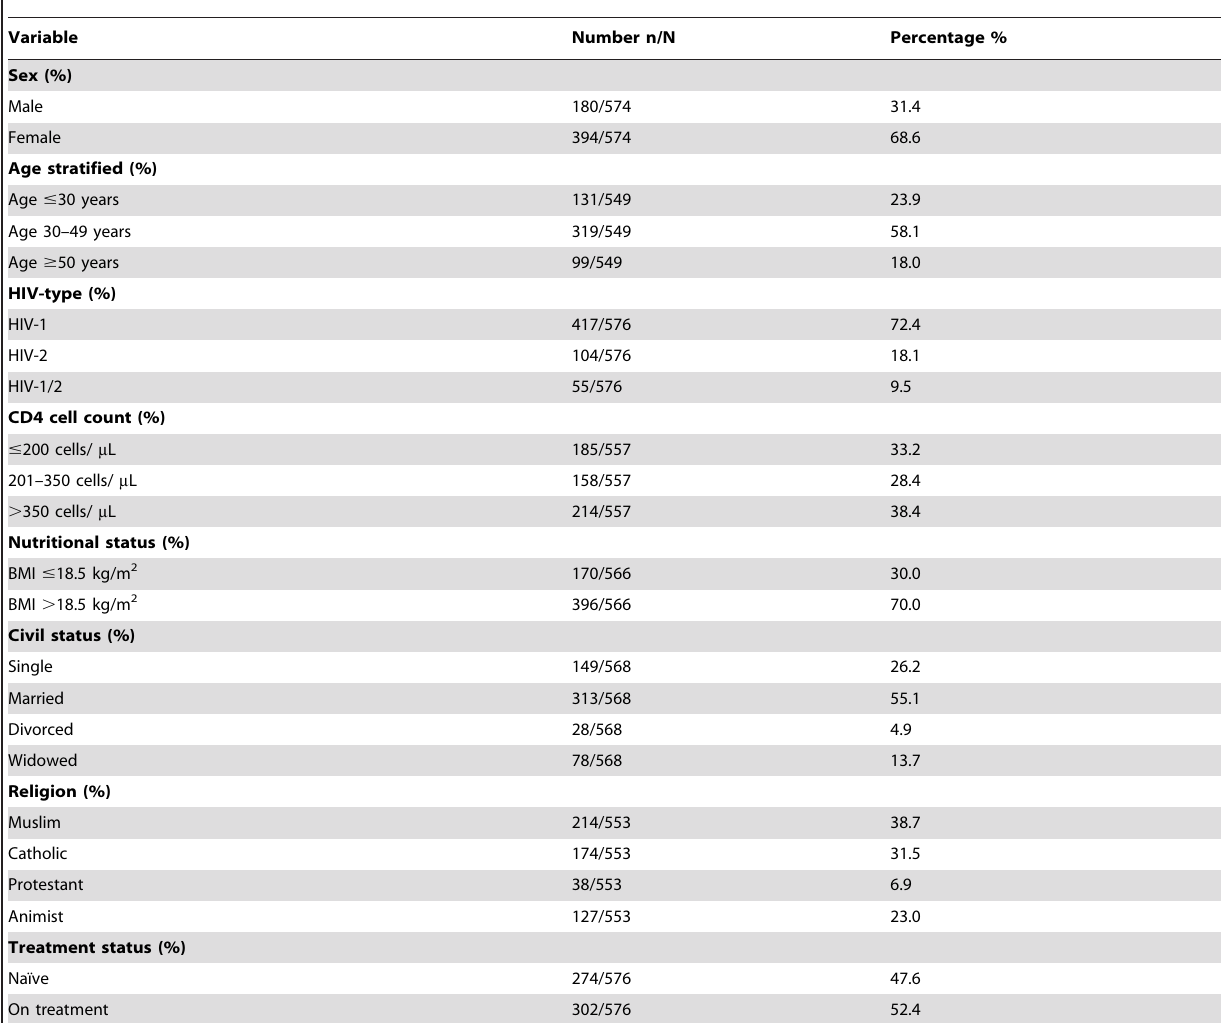
Table 1. Characteristics of the 576 included HIV infected